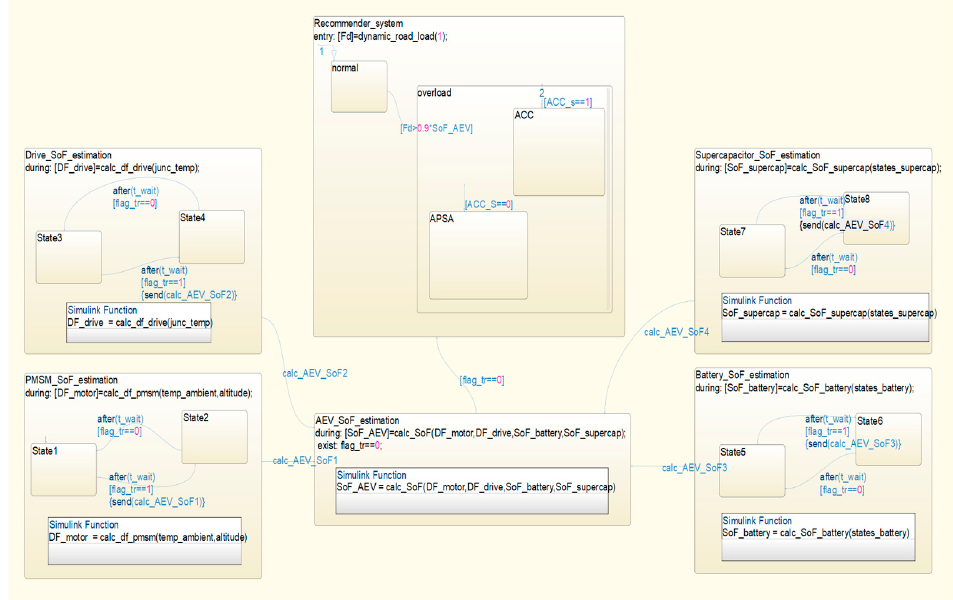
Figure 8. An overview of the implemented recommender system in STATEFLOW ©.